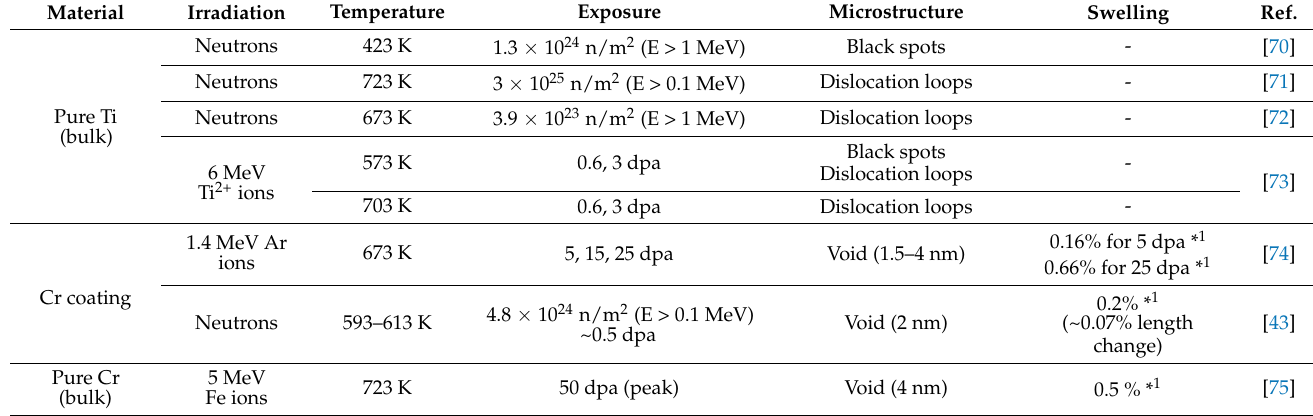
Table 3. Microstructure and swelling of pure Ti, pure Cr and Cr coating irradiated at temperatures from 423 to 723